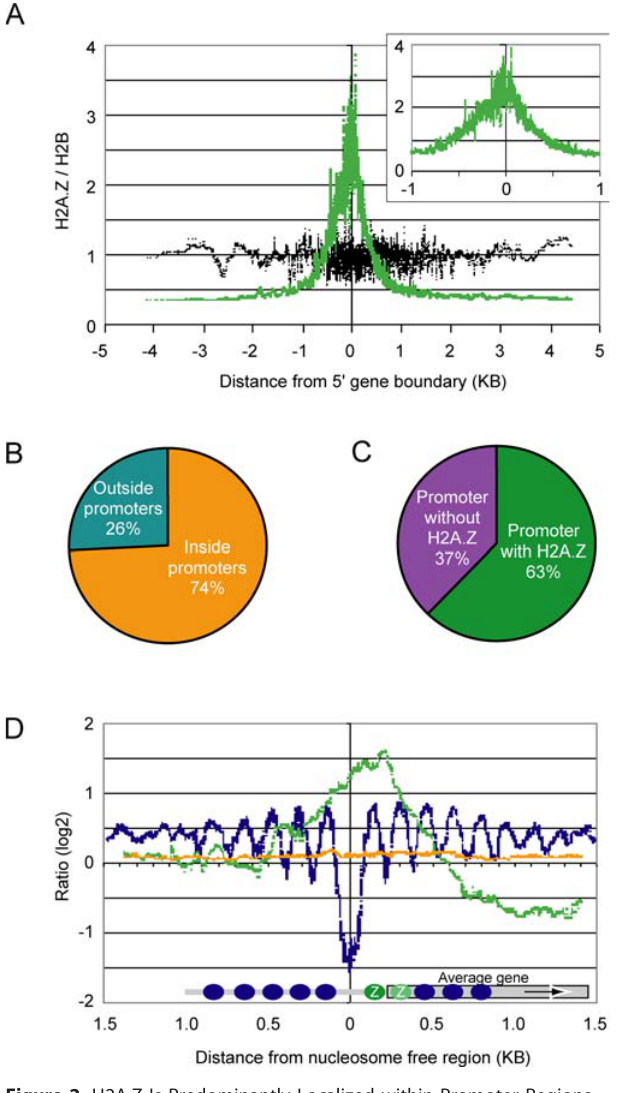
Figure 2. H2A.Z Is Predominantly Localized within Promoter Regions